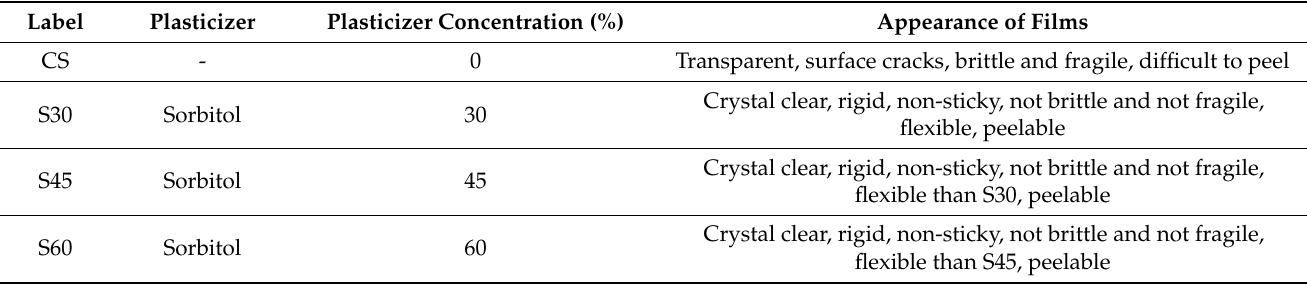
Table 1. General appearance of non-plasticized and plasticized CS